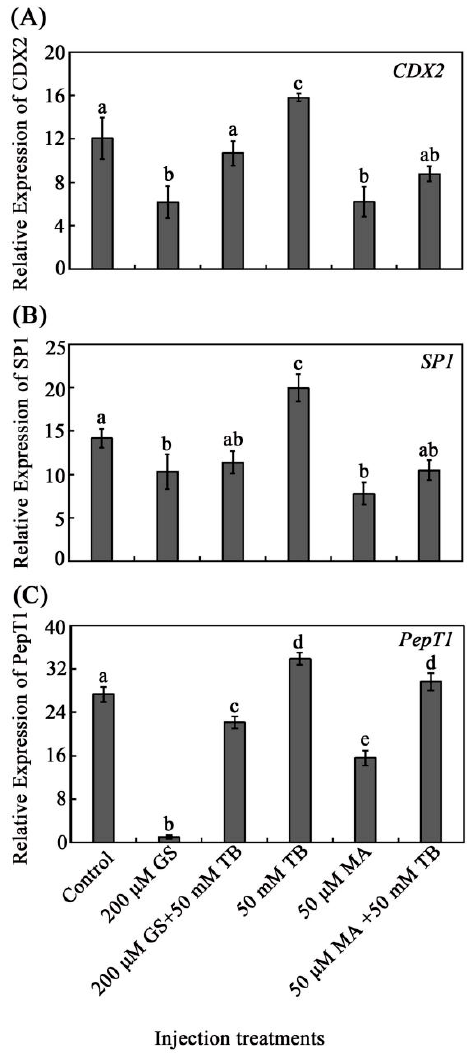
Figure 5. CDX2/SP1-mediated regulation of PepT1 by tributyrin. ( A ) The effect of indicated injection treatments on mRNA expression level of CDX2. ( B ) The effect of indicated injection treatments on mRNA expression level of SP1. ( C ) The effect of indicated injection treatments on mRNA expression levels of PepT1. The data represent the mean ± SD. Tukey’s multiple range test was performed, and different letters represent significant differences ( p < 0.05, n = 3 for each group with a total of 15 fish).